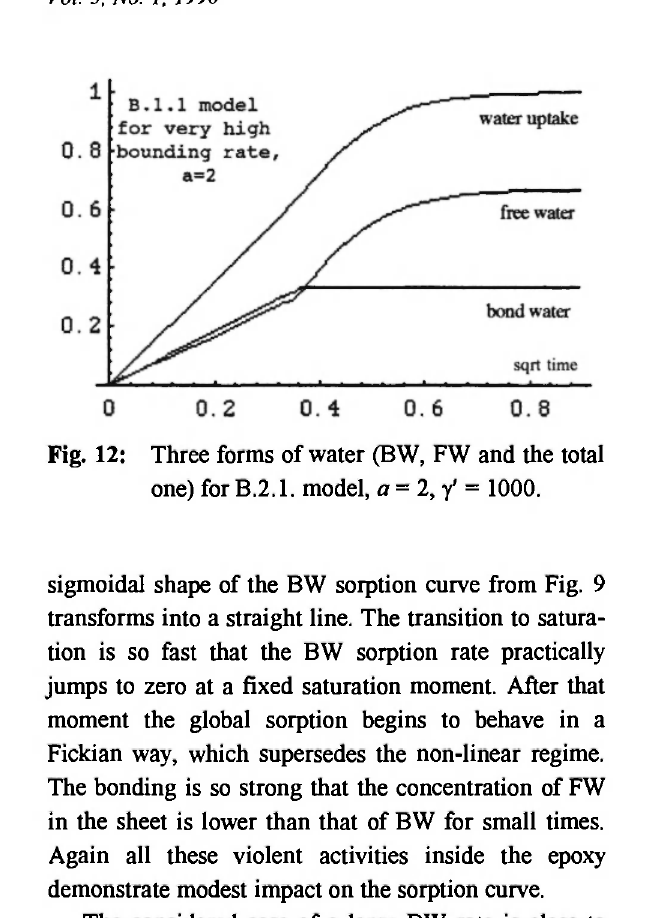
Fig. 14: Water uptake for fixed / = 1 and a = 1, 1/2, 1/10, 1/50.